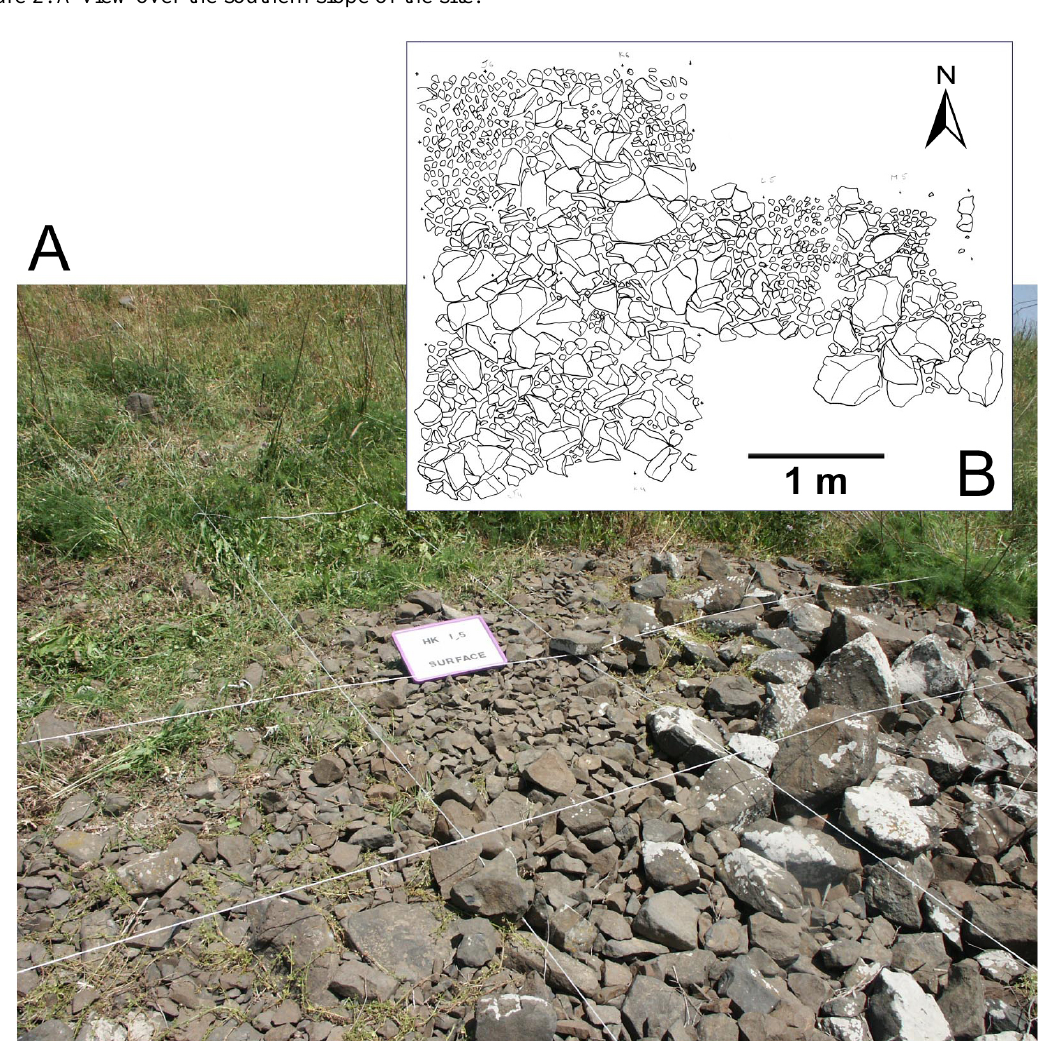
Figure 3. The centre of Locus 1 prior to excavation and a drawing of parts of its